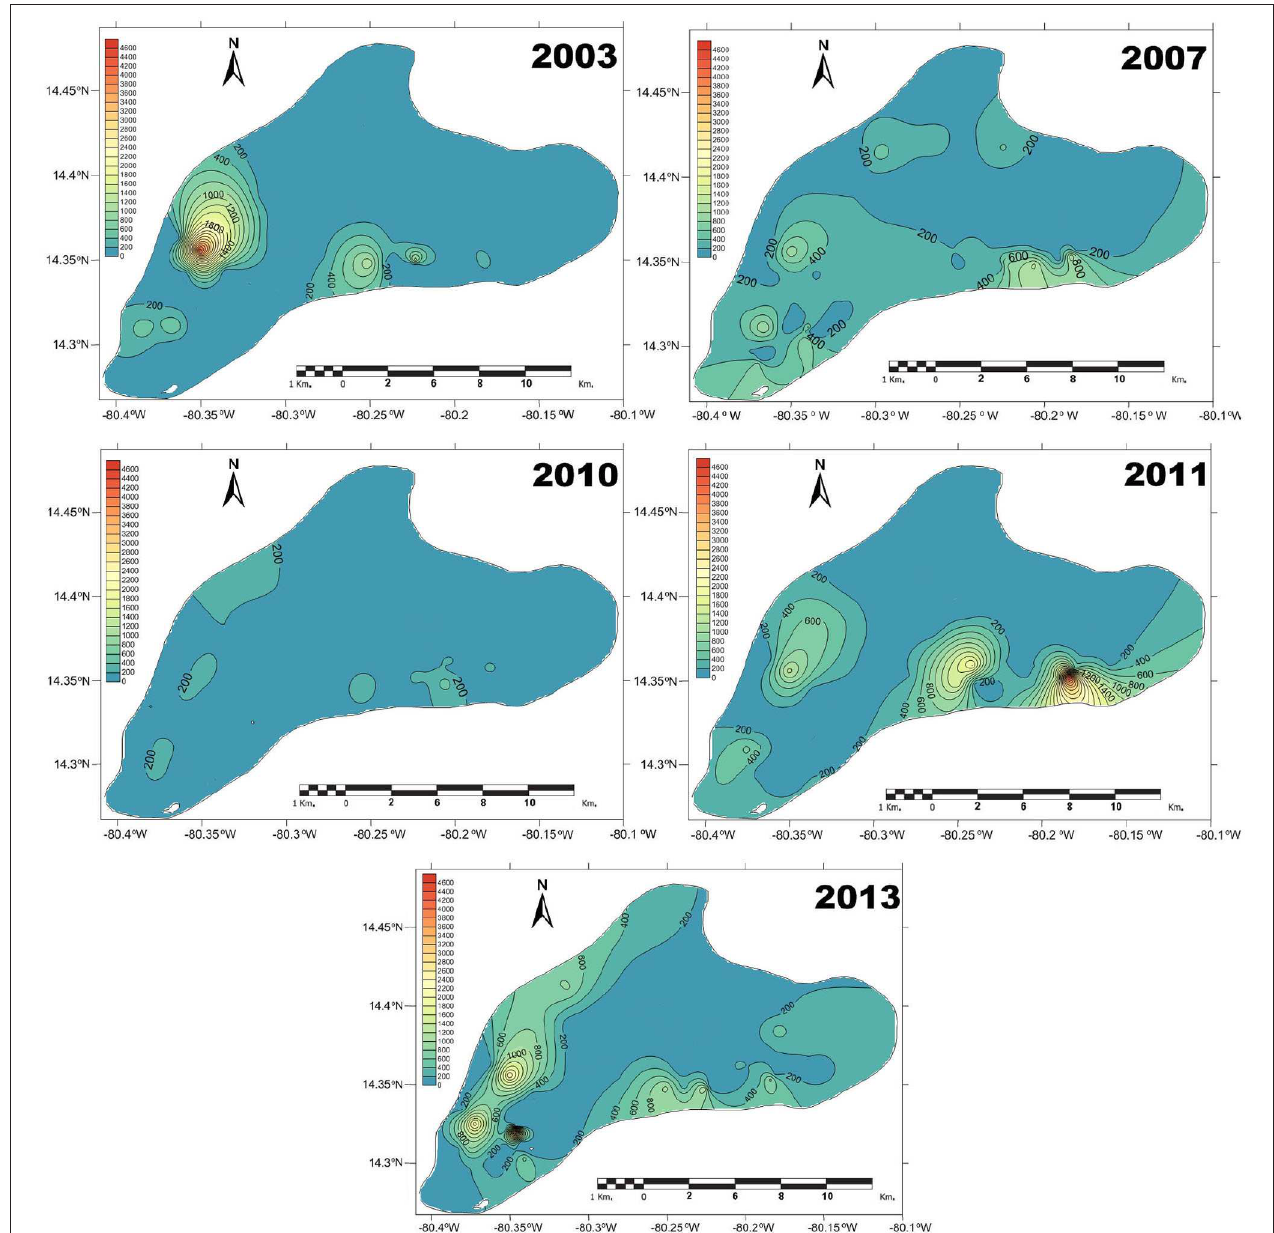
FIGURE 1 | Digital maps of A. gigas total density (ind. ha − 1 ) on Serrana Bank (2003–2013) using kriging prediction.